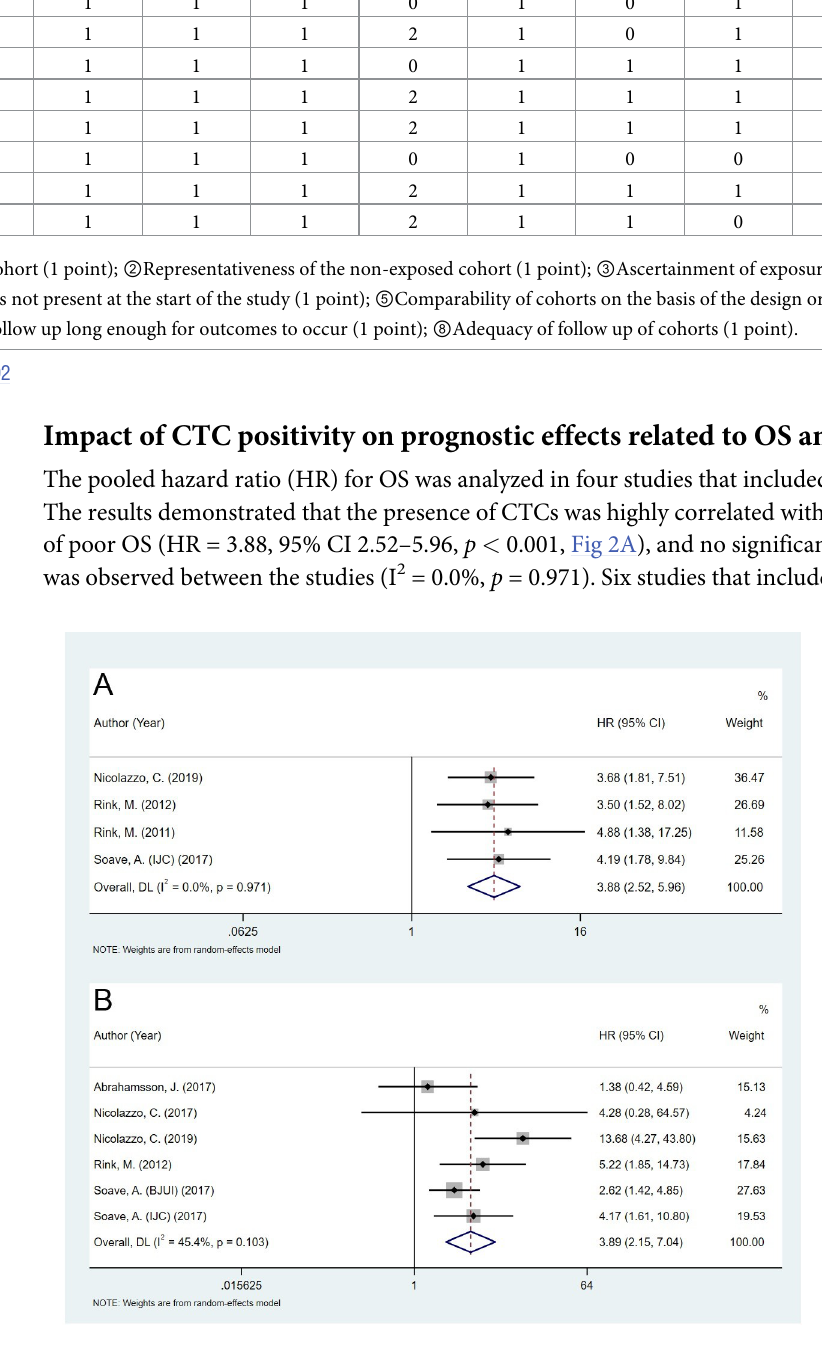
Fig 2. Pooled HRs for overall survival and cancer-free survival of patients in the included studies. A: overall survival. B: cancer-free survival.